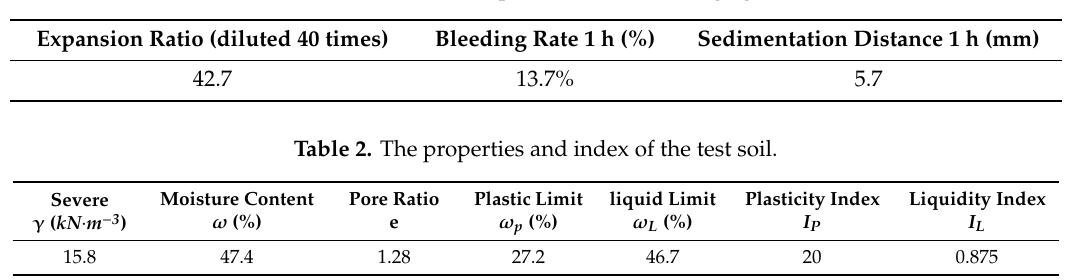
Table 1. Performance parameters of foaming agent.